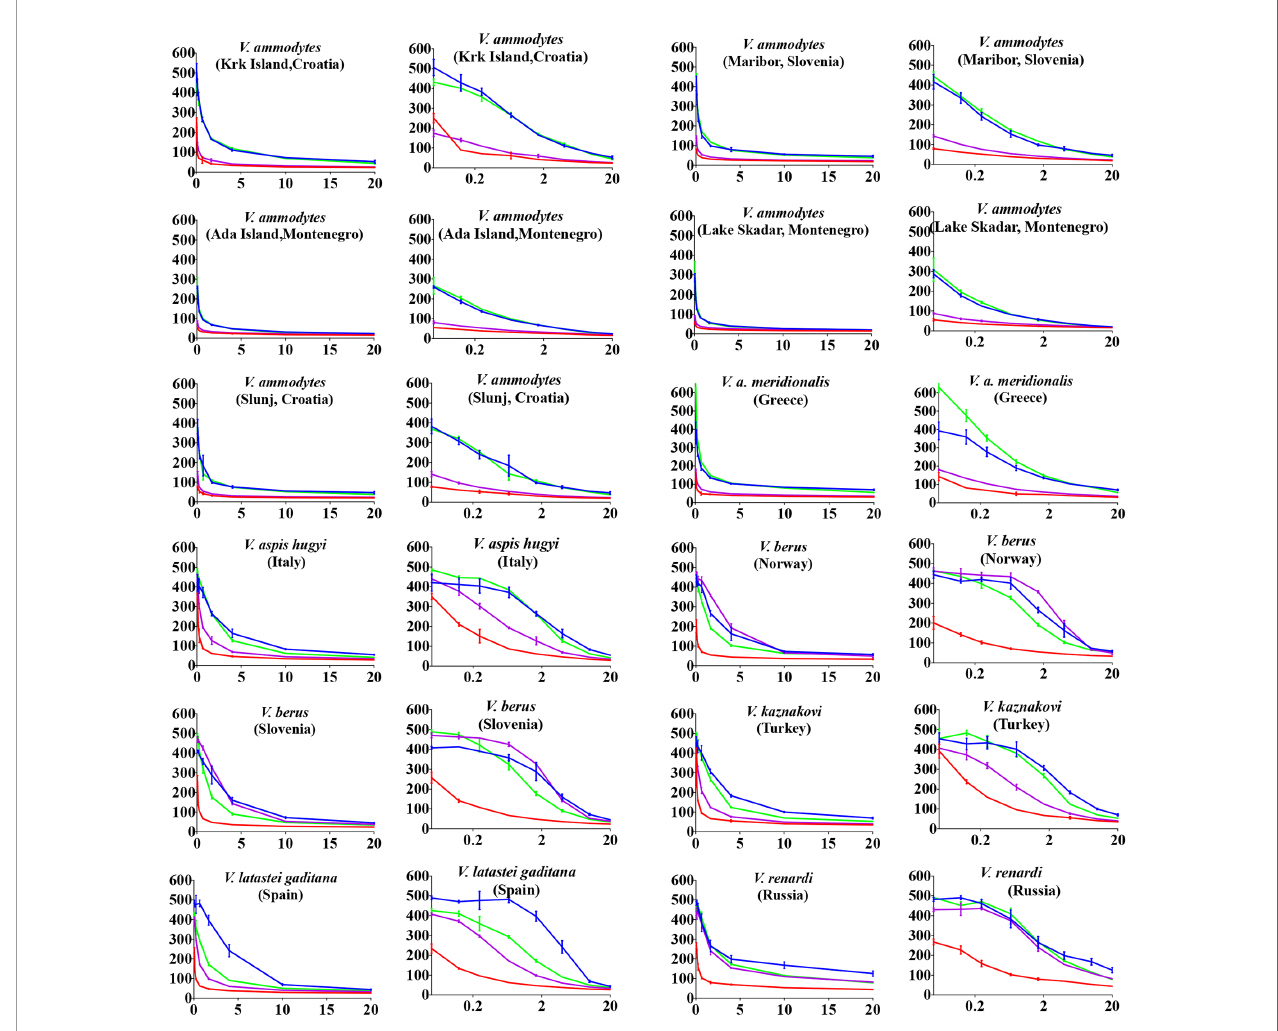
FIGURE 4 | 8-point concentration curves, x-axis showing concentrations of venom in m g/ml and y-axis showing clotting times in seconds of human plasma with venom and relative antivenom ef fi cacy. For each species, linear graphs are presented on the left and logarithmic views on the right. Shown are: venom-induced clotting times (red curves); venom-induced clotting times after preincubation with Inoserp AV ( fi nal concentration 0.5%; spontaneous control- 420.2 +/27.7) (blue curves), ViperaTAb AV ( fi nal concentration 0.4%; spontaneous control- 478.4 +/33.3) (purple curves), or VIPERFAV AV ( fi nal concentration 0.2%; spontaneous control- 509.7 +/13.5) (green curves). Values are mean ± SD of N = 3 and shown as dots with error bars. Some error bars are too small to